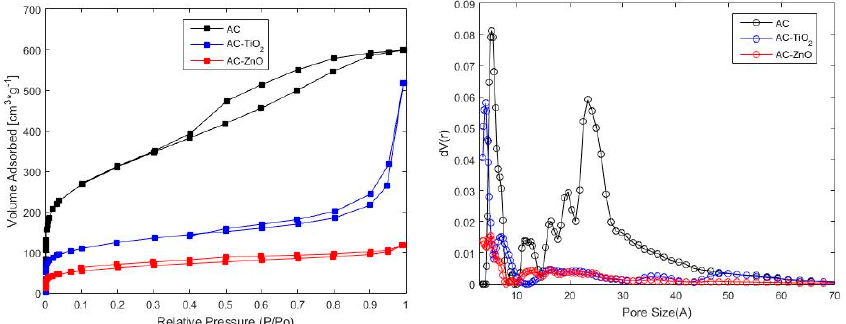
Figure 1. From left to right, nitrogen isotherms (77 K) and pore size distribution (PSD) calculated using the density functional theory (DFT) method.